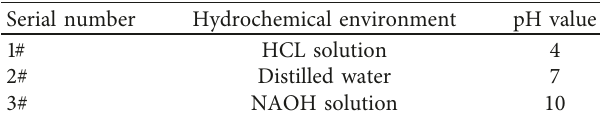
Figure 1: All shale samples used for creep test. Table 1: Hydrochemical environment.